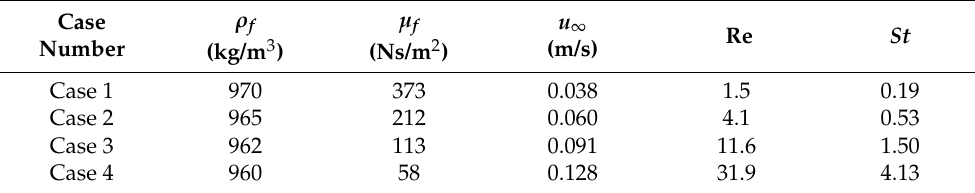
Table 1. Setup of single-particle sedimentation experiments.